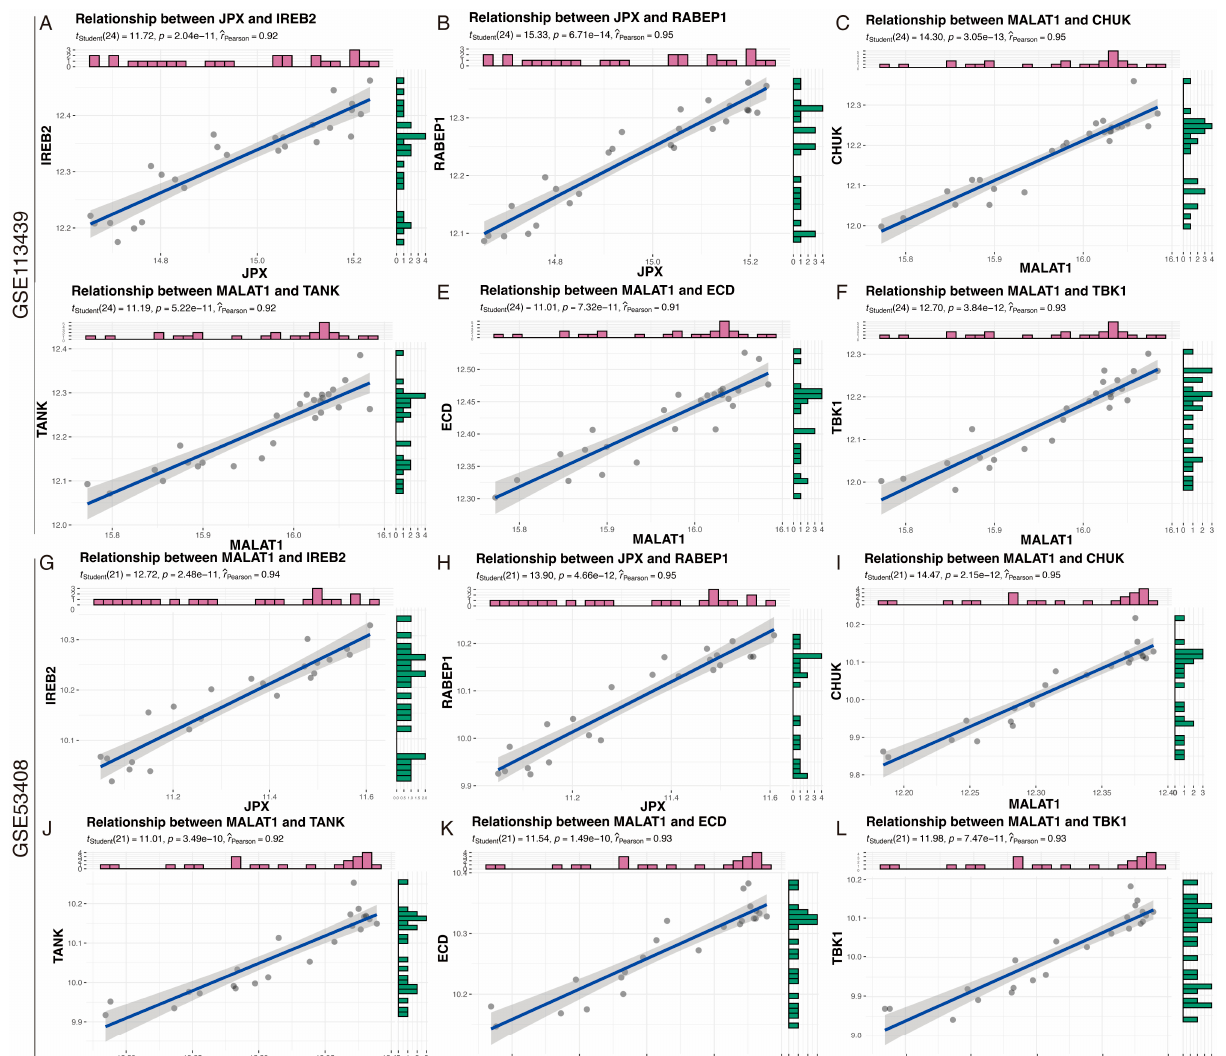
Figure 4. Validation of the correlation of immune-related lncRNA-mRNA pairs. ( A – F ) Correlation of immune-associated lncRNAs-mRNAs pairs in the GSE113439 dataset. ( G – L ) Validation of correlations of immune-related lncRNA-mRNA pairs in the validating GSE53408